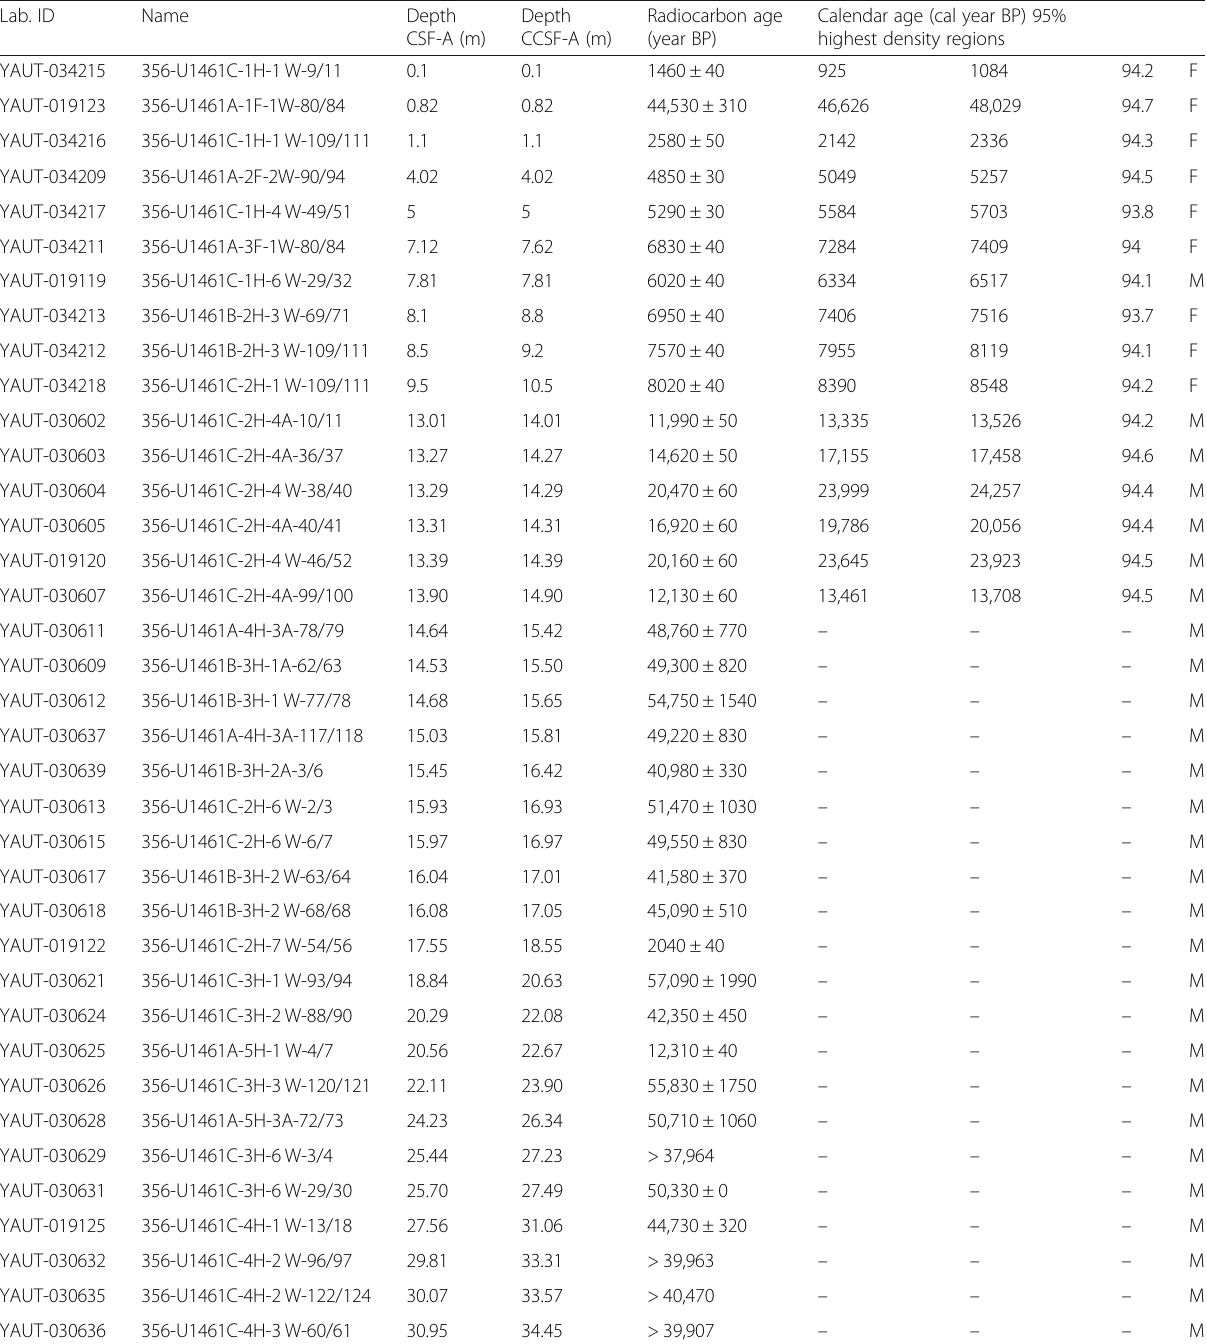
Table 1 Age results of Site U1461 Lab.